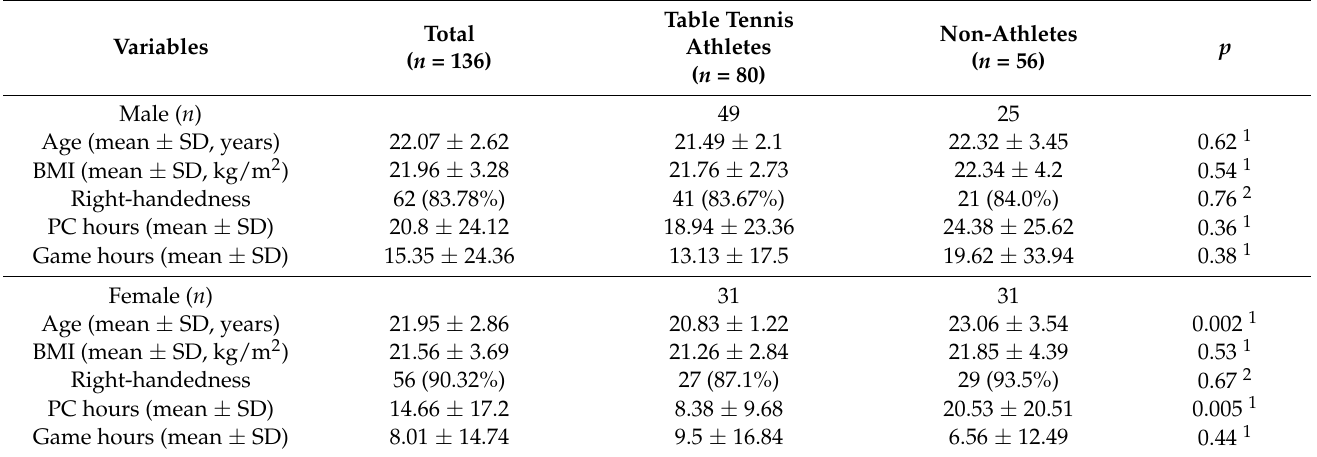
Table 1. Demographic characteristics between table tennis athletes and non-athletes by sex ( n = 240). Table Total Variables